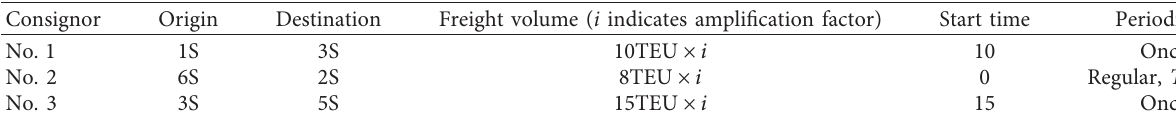
Table 2: Consignors information.